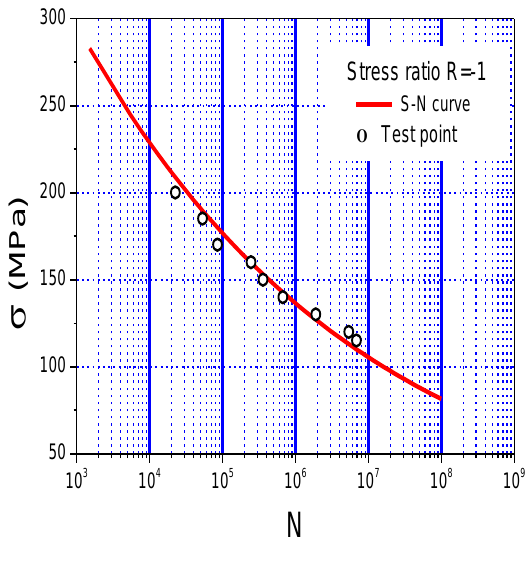
Figure 23. Comparison results of test results and the S-N